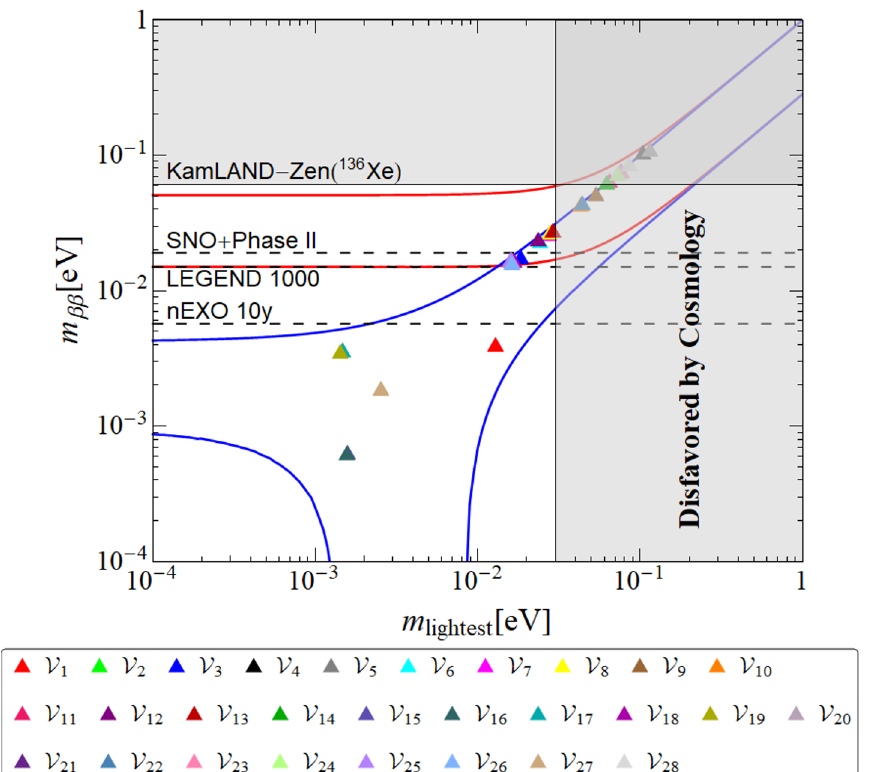
Figure 4 . The predictions for the effective mass of the neutrinoless double beta decay for the type V models. We adopt the same convention as figure